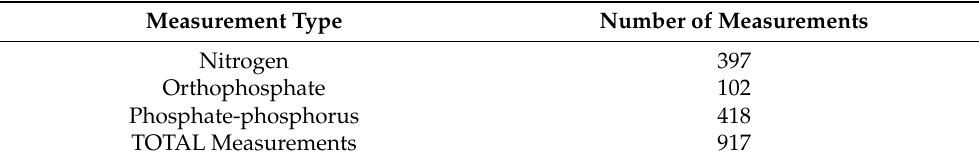
Table 2. Utah Lake BYU measurements uploaded to the WQDV database.